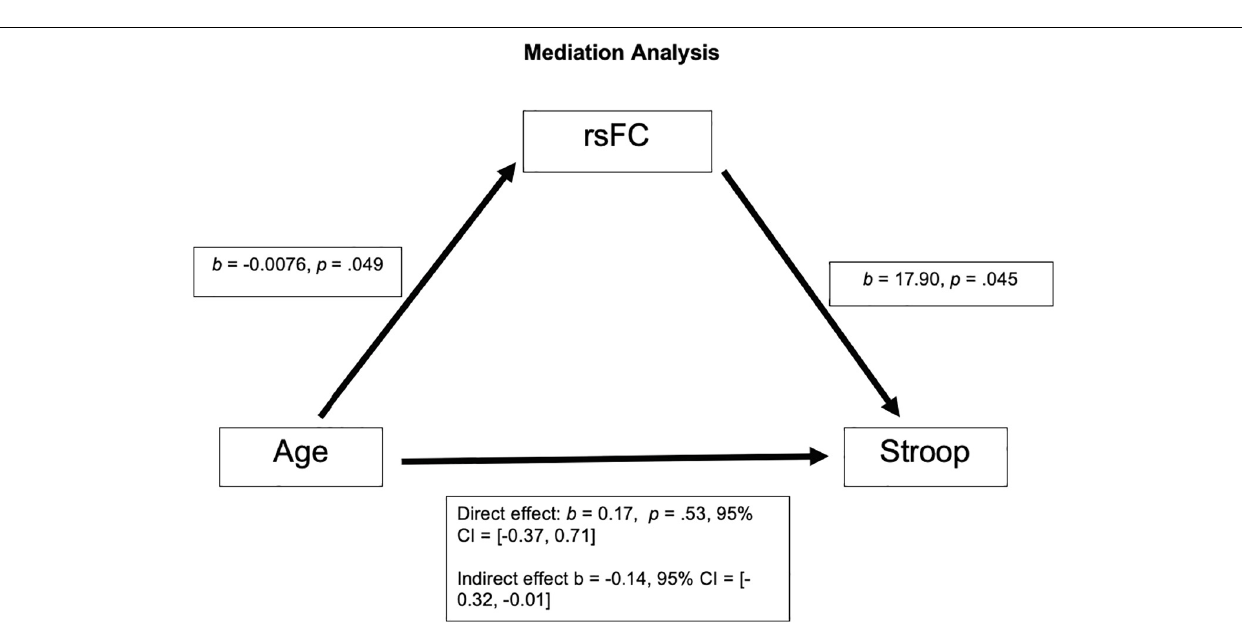
FIGURE 1 | The two brain regions used in our resting state functional connectivity analysis of the salience network, the dorsal anterior cingulate cortex ( x = 10, y = 34, z = 24) and left anterior insula ( x = –32, y = 24, z = –10) adapted from Seeley et al. (2007) (A) . This panel also presents scatterplots between resting state functional connectivity (rsFC) of the salience network and Age; r (63) = –0.25, p = 0.049 (B) , between rsFC of the salience network and Stroop calculated interference score; r (63) = 0.24, p = 0.055 (C) , and between Stroop calculated interference score and Age; r (63) = 0.017, p = 0.89 (D)